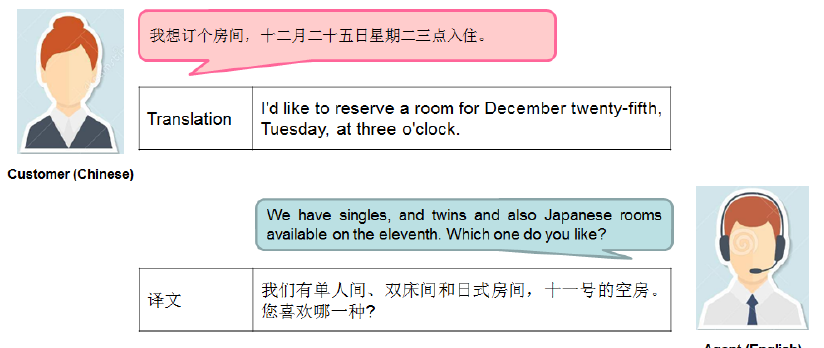
Figure 3. An example of task-based dialogue translation. It is extracted from the Chinese-English IWSLT-DIALOG